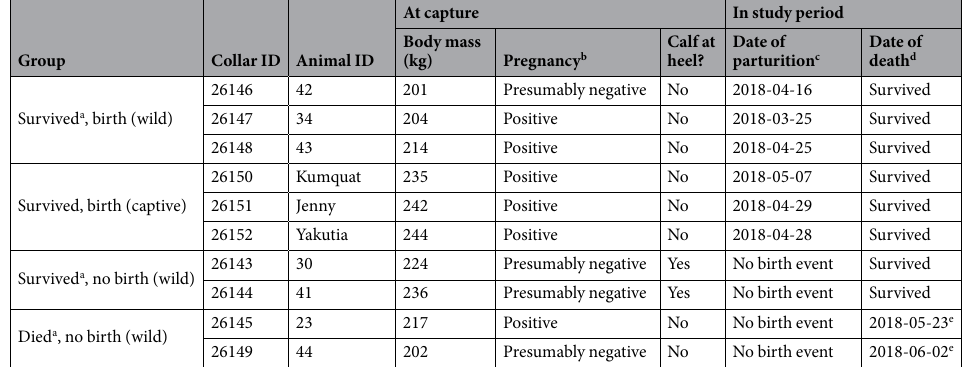
Table 1. Metadata for all muskox at the time of handling, including their pregnancy status and fate during the study period. Notes: a Based on GPS location data and ground observations, b Based on ultrasound examinations and analyses of serum samples, c Based on VIT readings, d Based on VIT readings and GPS location data, e The carcass of muskox #26145 was located and examined two days after death. At that time, the weight of the still intact carcass was 97 kg, corresponding to a 55% loss of body mass since autumn. No evidence of the foetus was found. Muskox #26149 was confirmed dead, but no body mass could be